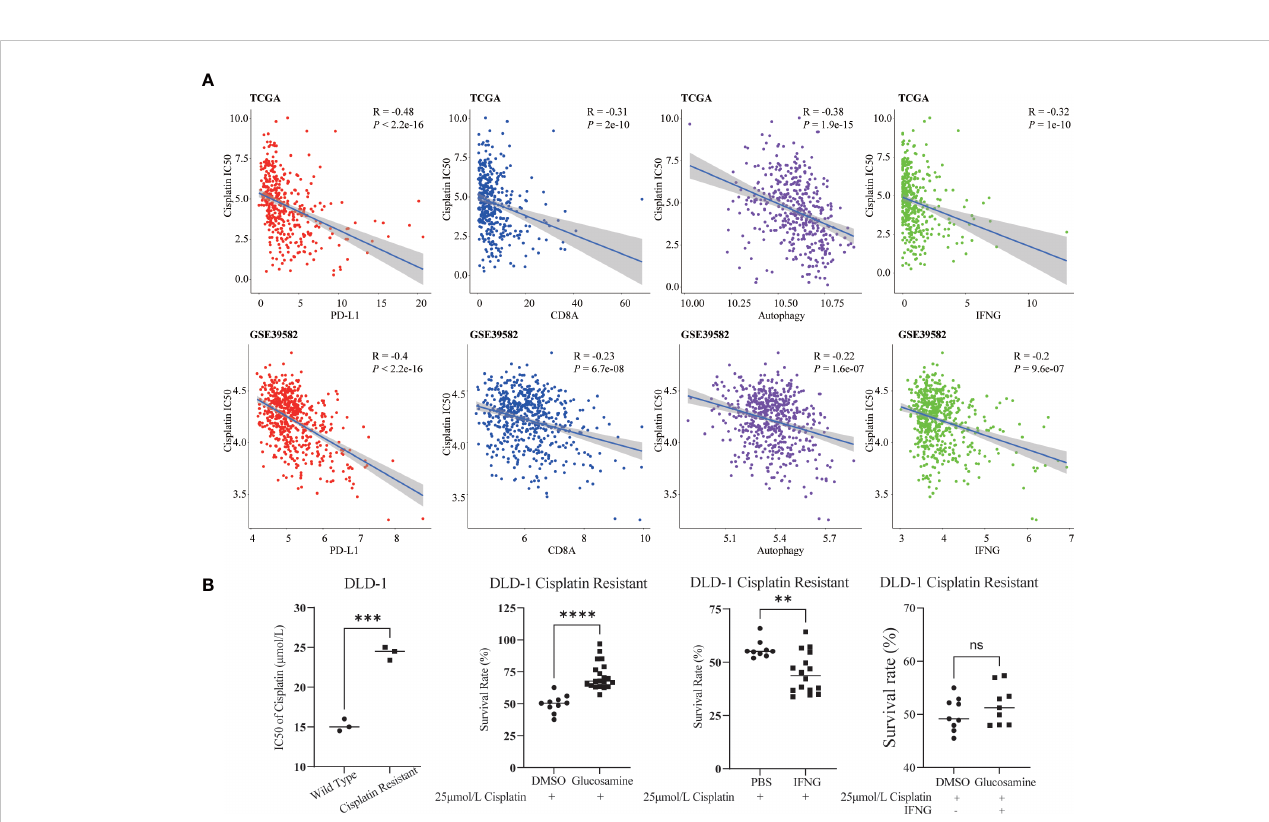
FIGURE 12 Relevance of cisplatin chemotherapy. (A) In two COAD cohorts, similar to PD-L1 and CD8A, autophagy score and IFNG were signi fi cantly correlated with cisplatin IC50. (B) Compared with wild type DLD-1, the cisplatin IC50 of drug resistant DLD-1 was signi fi cantly upregulated (***: P-value <0.001). In cisplatin resistant DLD-1, in combination with cisplatin IC50, glucosamine increased the survival of drug-resistant cells, while IFNG decreased the survival; After glucosamine administration, IFNG could reverse the increase of cell survival (**P-value <0.01; ****P-value <0.0001; ns, P-value >0.05).